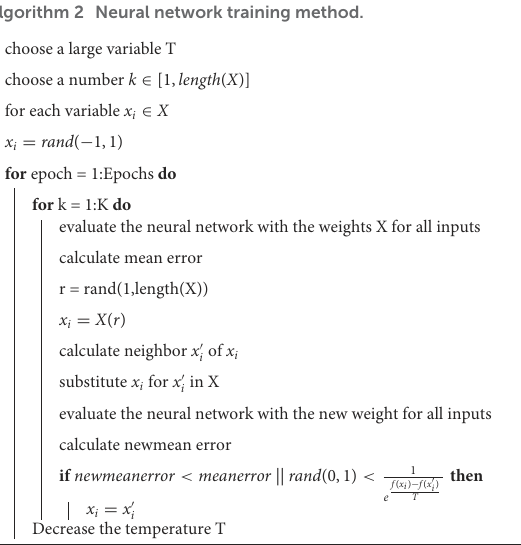
Algorithm 2 Neural network training method. choose a large variable